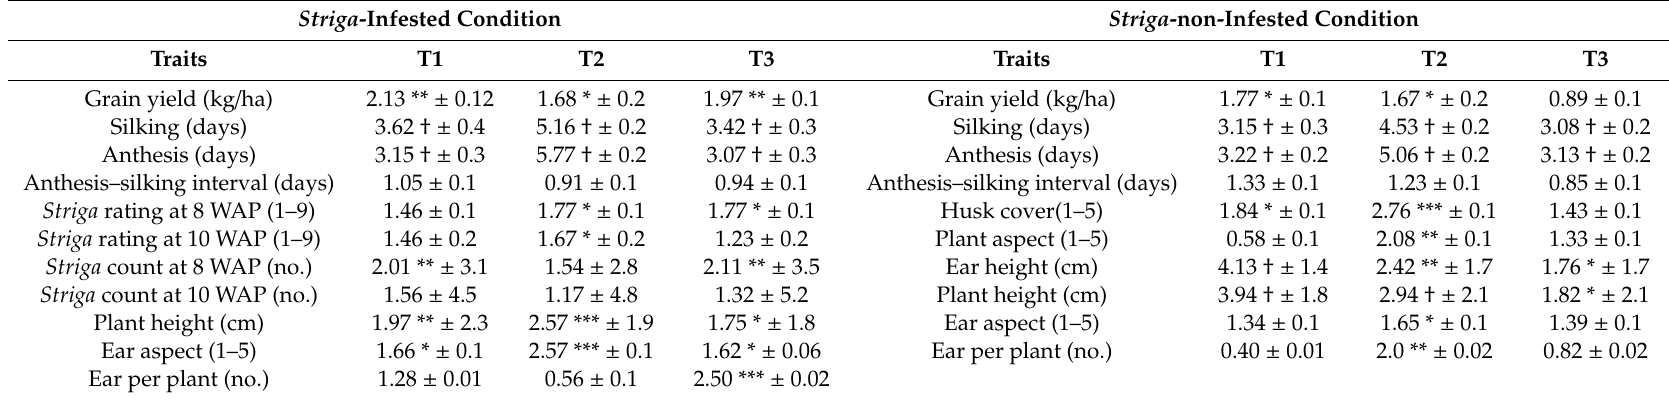
Table 3. Estimates of genetic variance and standard error for each tester across four environments under Striga -infested and non-infested